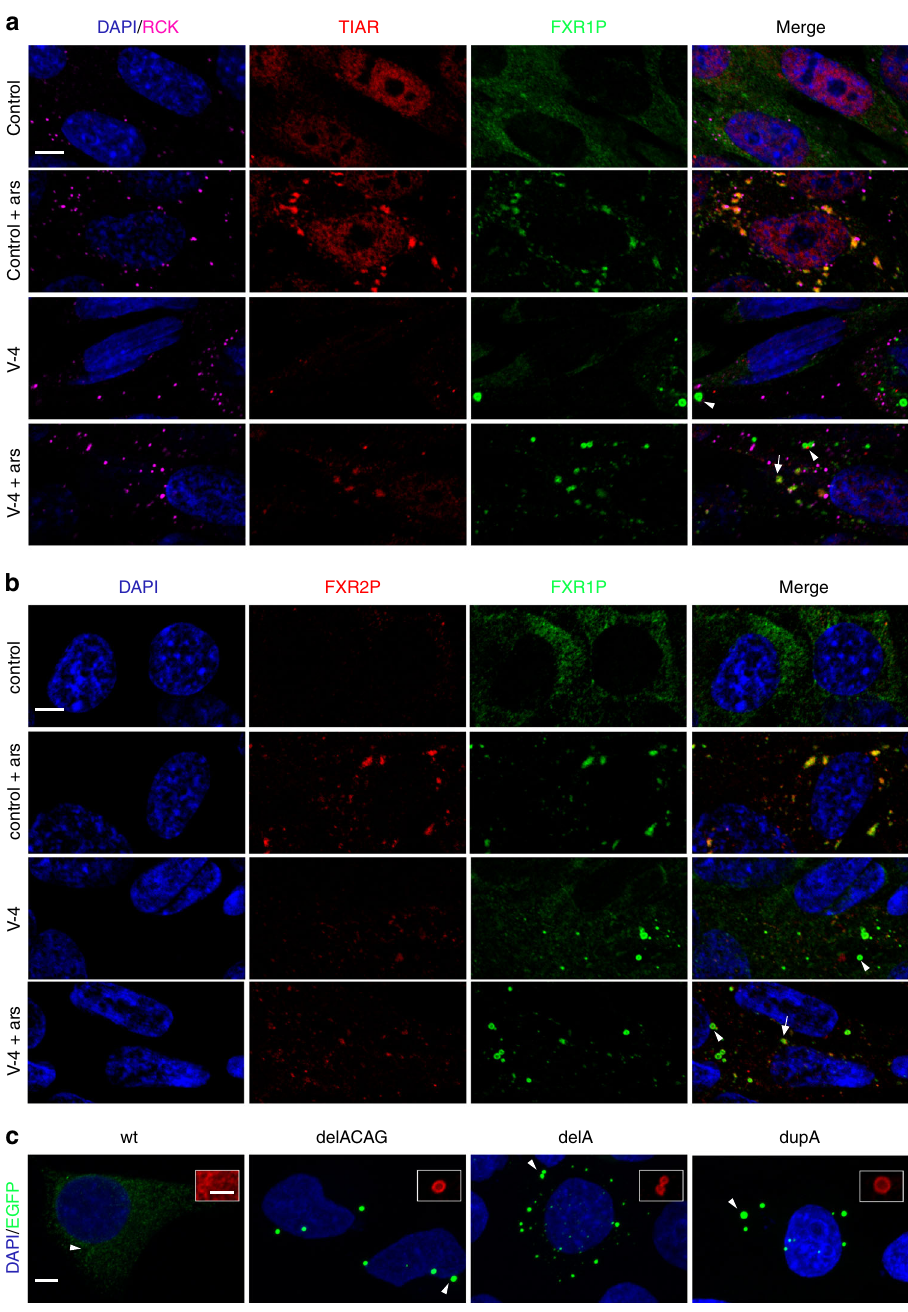
Fig. 9 DelACAG granules do not recruit SG components. a , b Representative images of confocal microscopy (single Z-slice) from one-day differentiated V- 4 or control myoblasts treated with or without ARS and co-immunostained for FXR1P and TIAR/RCK or FXR2P. Strong co-localization of FXR1P with TIAR and FXR2P occurs in amorphous SG granules (arrows), but not in ring-shaped delACAG granules (arrowheads). n = 4(TIAR/RCK), n = 3(FXR2P). Scale bars 5 µ m. c Confocal (Z-project) representative images of transfected HeLa cells with EGFP:FXR1P-iso-e fusion proteins (Supplementary Fig. 10a) illustrating assembly of the three mutant proteins (delACAG, delA, and dupA) into ring-shaped delACAG-like granules. Equivalent images of transfected HeLa cells labeled with anti-FXR1P are in Supplementary Fig. 10c. Scale bar 5 µ m. Higher magni fi cations correspond to anti-FXR1P staining of the areas designated by arrowheads. n = 3. Scale bar 2 µ m. In all panels nuclei are stained with DAPI Genetic analysis . Homozygosity mapping in the proband of family 1 was con- annotated using Ensembl database (www.ensembl.org). The fi ltering pipeline is in ducted by whole-genome SNP-array hybridization using CytoSNP-850k BeadChip Supplementary Table 1a. SNP-array hybridization in V-4 was performed as in the SNP-based arrays (Illumina) as indicated in Palencia-Campos et al 45 . For this proband after biological material became available. Multiplex Ligation-dependent Probe Ampli fi cation (MLPA) of the SMN locus was accomplished using SALSA proband WES was provided by Sistemas Genomicos S.L. (Valencia, Spain). Tar- probe mix P021 (MRC-Holland) according to the manufacturer speci fi cations. For geted regions were captured using SureSelect Human All Exon Target Enrichment WES in family 2 individuals, 2× 100 bp paired end sequencing was carried out kit for 51 Mb (Agilent Technologies) and reads were aligned against human gen- using the Illumina Hi-Seq 2000 platform after target enrichment of 6.5 µg of ome assembly GRCh37/hg19. Initial fi ltering was performed with Picard-tools genomic DNA with the Agilent SureSelect Human All Exon 50Mb Capture kit. (http://broadinstitute.github.io/picard/) and SAM-tools 46 and variant calling was Overall mean exon coverage was 177 – 190X with ≥ 20X base coverage of 96.7-97.6%. obtained using combination of VarScan 47 and GATK 48 . Identi fi ed variants were NATURE COMMUNICATIONS| (2019) 10:797